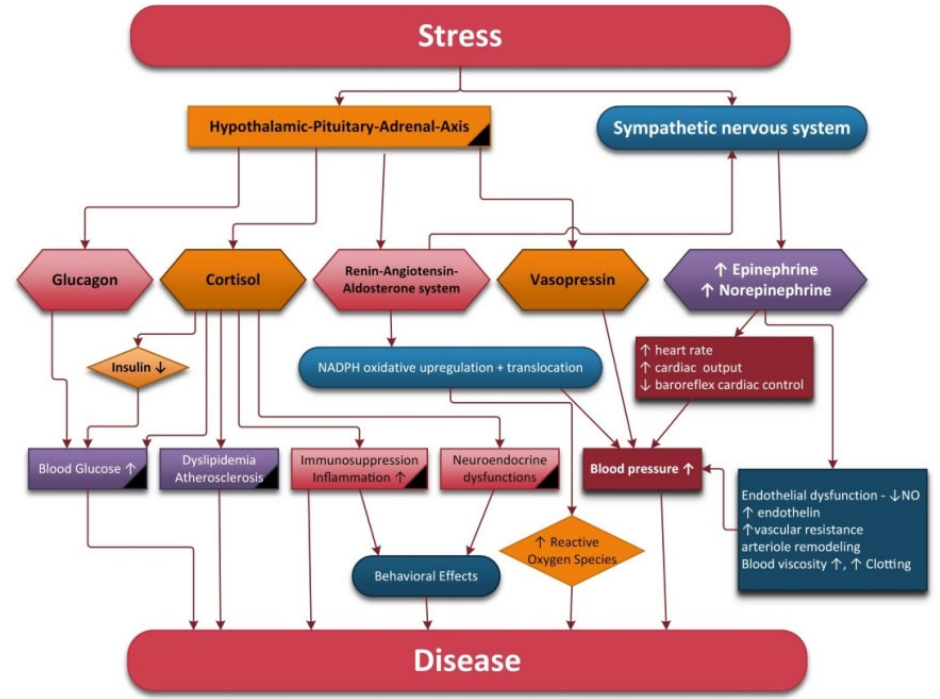
Figure 2. Physiological modifications under stimulation of the hypothalamic–pituitary–adrenal axis and sympathetic nervous system.